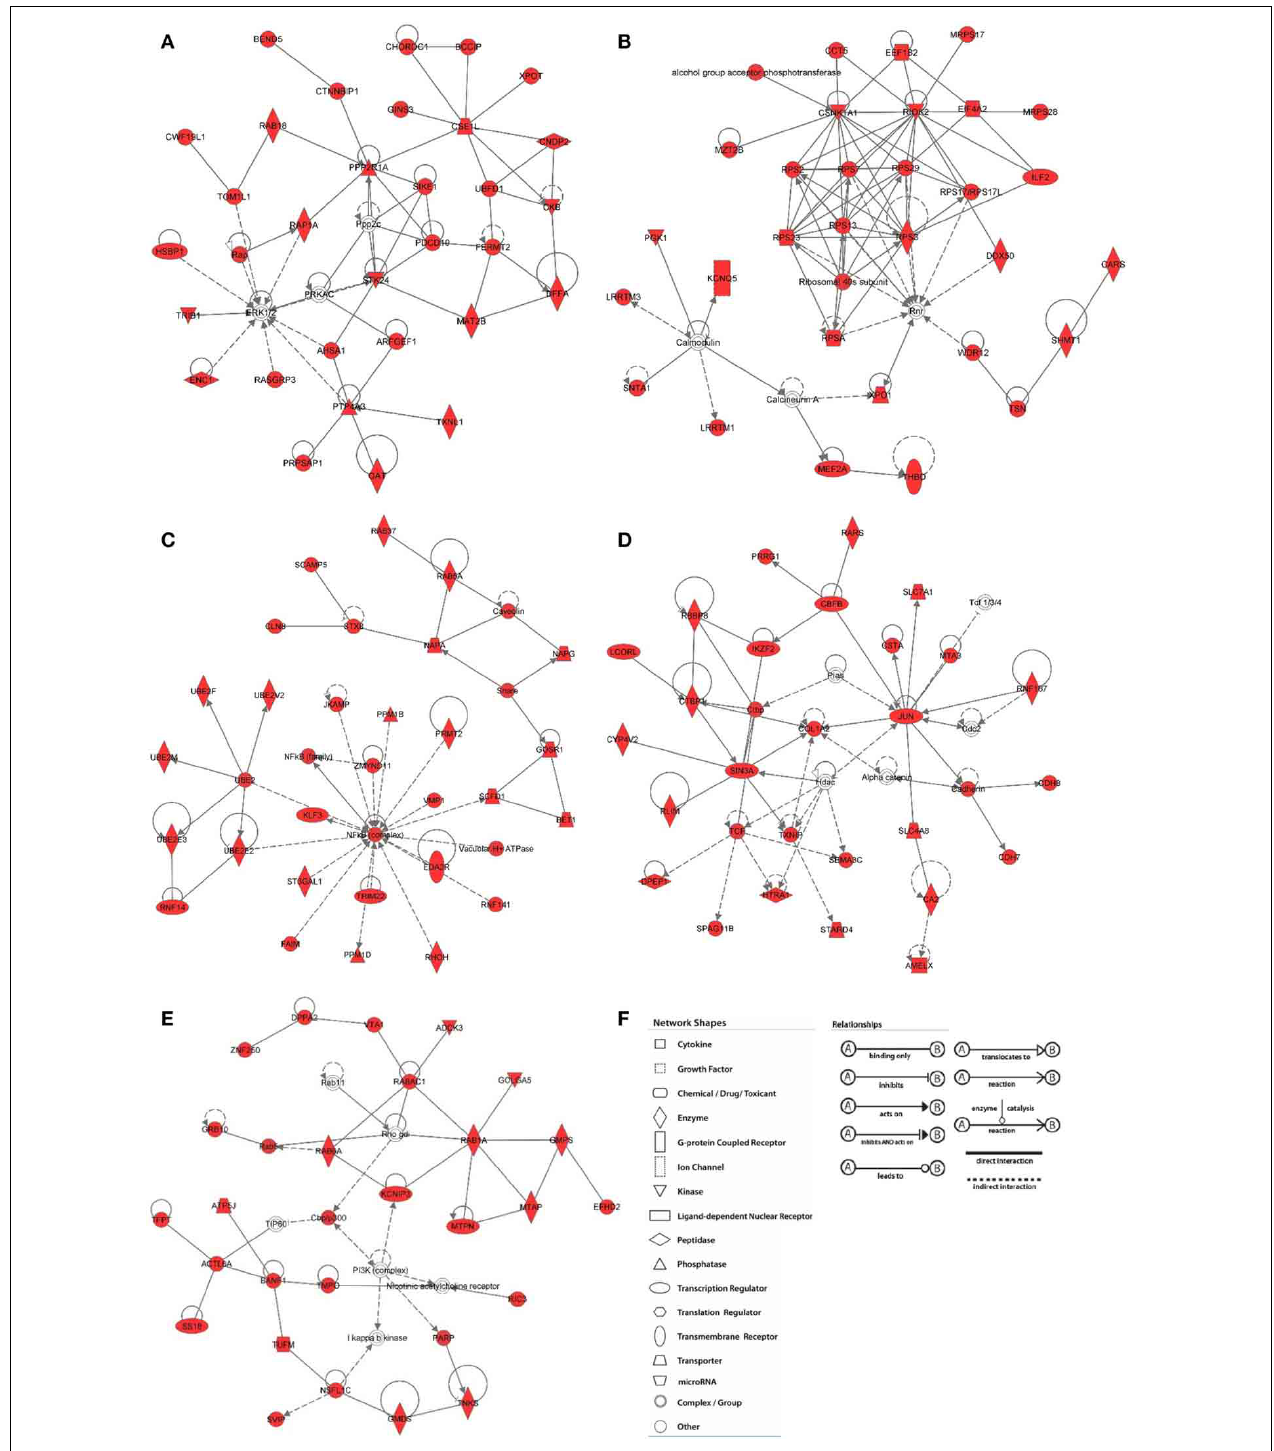
FIGURE 5 | Network analysis of H3K9me3 enriched genes in baboon SVZ cells. Top networks were predicted by Ingenuity Pathway Analysis software. The shaded focus genes (red highlight) were enriched with H3K9me3 identified by ChIP-Seq analysis. Node shape reflects the role of each element